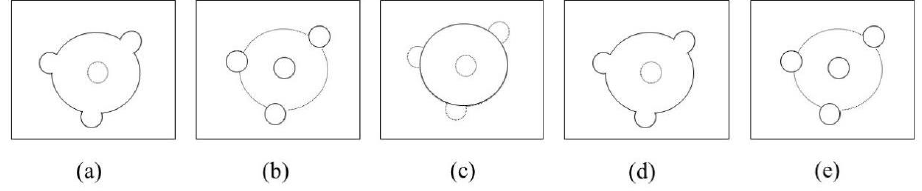
Figure 8. Demonstration of the judgment process when there is more than one treetop in the fine layer. Combined layer ( a ), fine layer ( b ), coarse layer ( c ), final output layer if all the Spectral Angle the threshold ( e